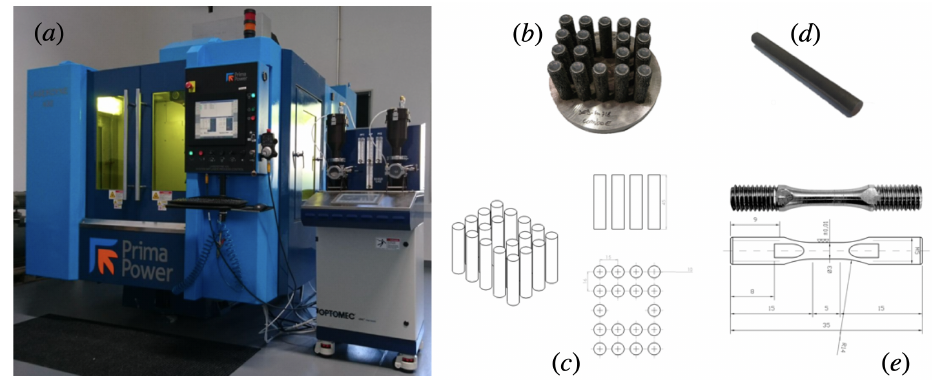
Figure 1: Laserdyne 430 laser cutting machine ( a ), additively manufactured cylinders ( b and c ), single cylinder after EDM trimming ( a ) and final as-built sample geometry after diamond grinding and turning ( e ).